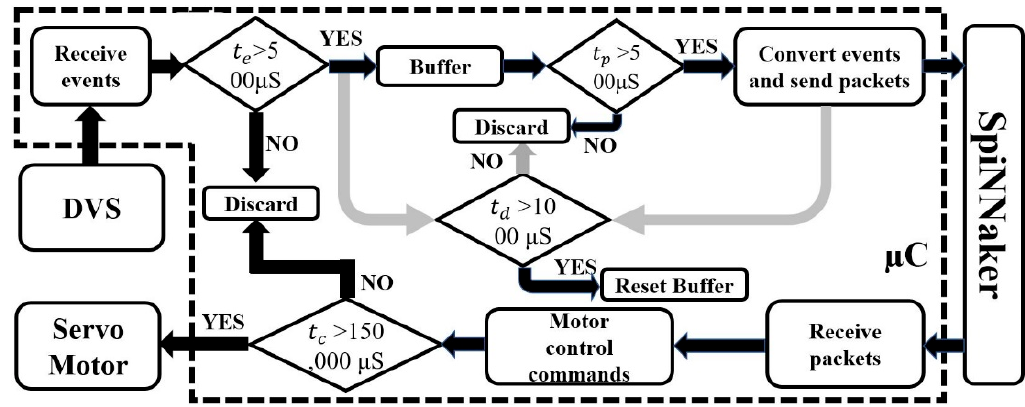
Figure 5. Synchronization of events, spikes and commands at the assumed maximum rate of 2000 packets/s for the SpiNNaker input spikes.